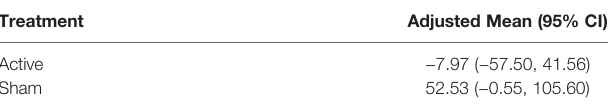
TABLE 6B | Summary of Mixed Model for Percent Change in Mean HDRS.